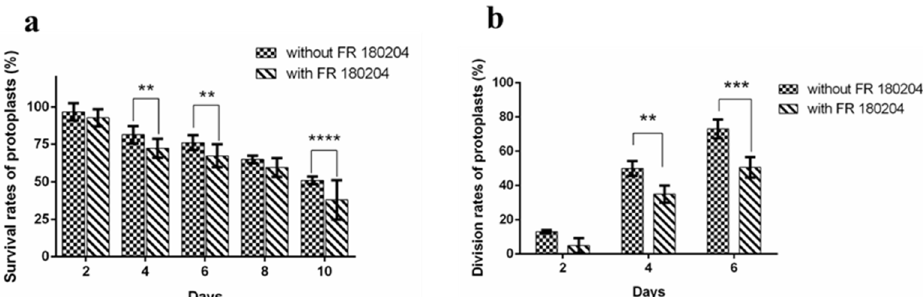
Figure 10. Effects of ERK inhibitor FR 180204 on the survival and division rates of protoplasts: ( a ) the changes of survival rates of protoplasts; ( b ) the changes of division rates of protoplasts. Data represent mean ± standard errors ( n = 3). ** p < 0.01, *** p < 0.001, **** p < 0.0001, vs. without FR 180204.